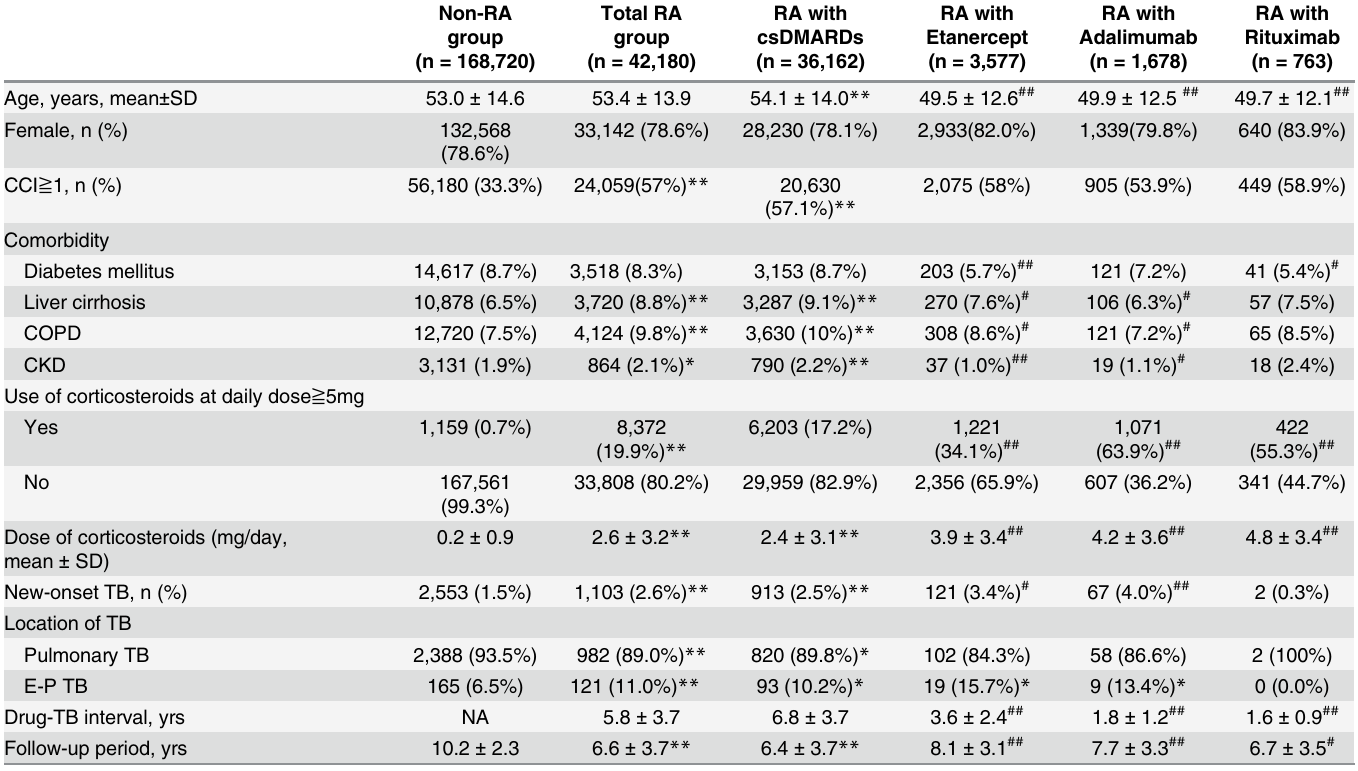
Table 1. Baseline characteristics and the occurrence of tuberculosis (TB) in rheumatoid arthritis (RA) patients and age- and gender-matched indi- viduals from the general population 2001 – 2011 (n = 210,900).